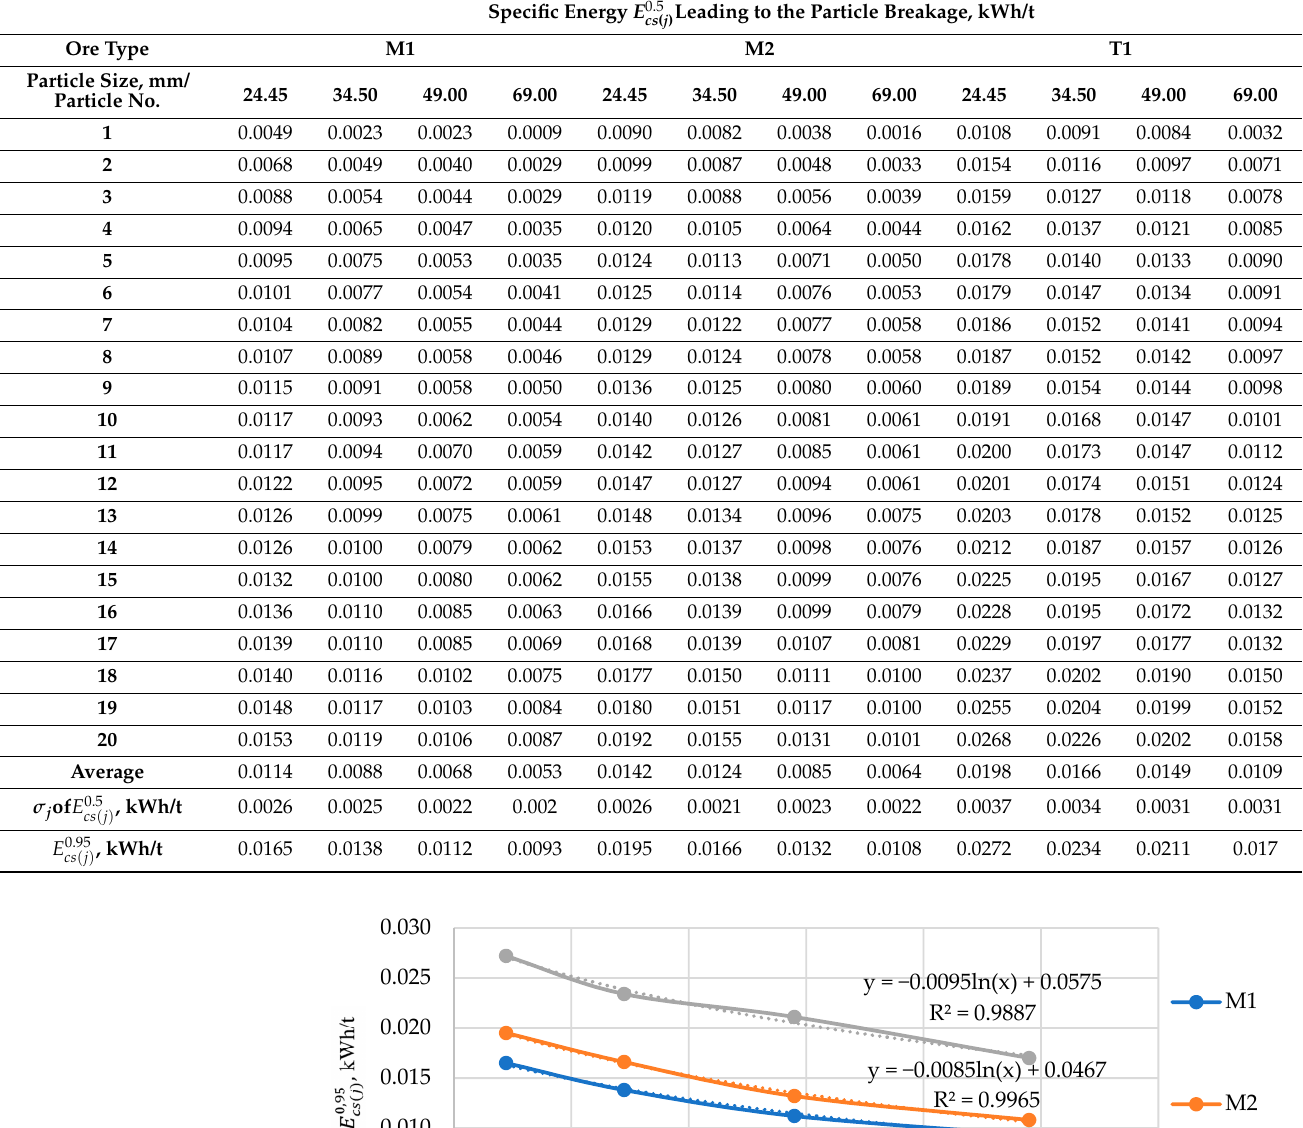
Table 5. Nominal specific particle’s breakage energy of various sizes of the studied ore types. Specific Energy 𝑬 𝒄𝒔(𝒋)𝟎.𝟓 Leading to the Particle Breakage, kWh/t